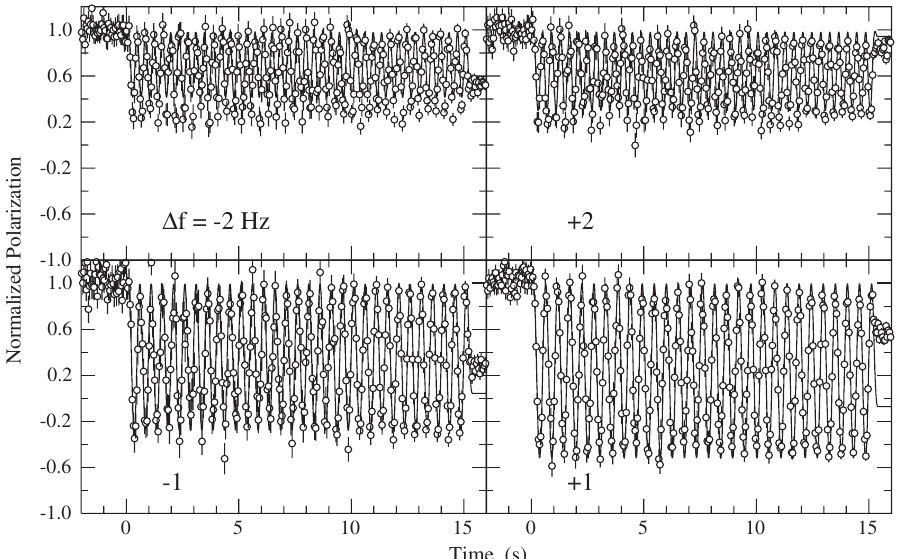
FIG. 10. Measurements of the vertical component of the polarization (normalized to one at the beginning of the process) with the rf-solenoid frequency displaced from the nominal resonance frequency of 871 434 Hz by an amount (cid:1) f as shown in each panel. The rf solenoid was on for 15 s and then turned off. The rf solenoid operated at a strength of (cid:3) ¼ 4 : 43 (cid:2) 10 (cid:1) 6 rev = turn (higher than for the data for Fig. 9 because of a change in the rf power). The line represents a calculation made to match the frequency of the polarization oscillations by changing the value of (cid:1) f by a fraction of one Hz (see Table III). The calculations involved only one particle track and no synchrotron oscillations.